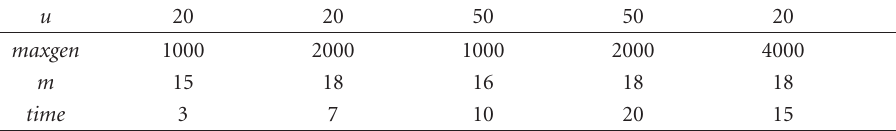
Table 4.3. Search results of 5 di ff erent parameter values for a 10-dimensional set by our approach. u